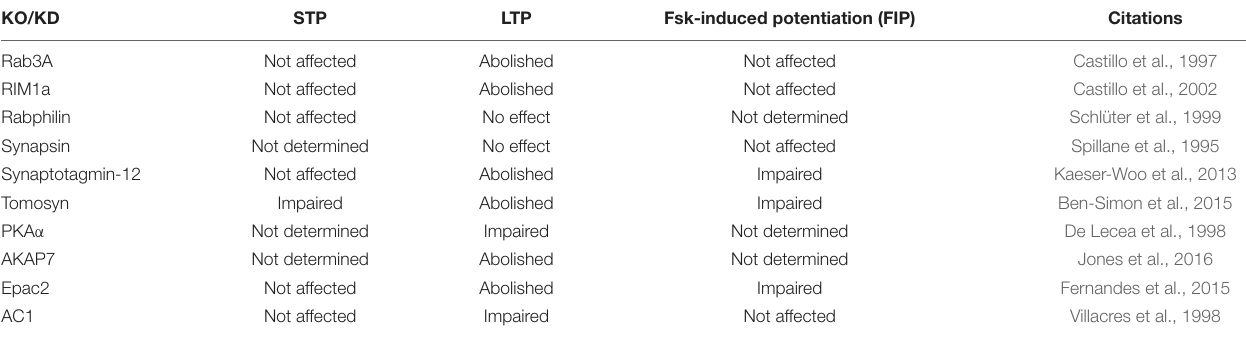
TABLE 1 | The effects of manipulation of proteins on hippocampal mossy fiber synaptic